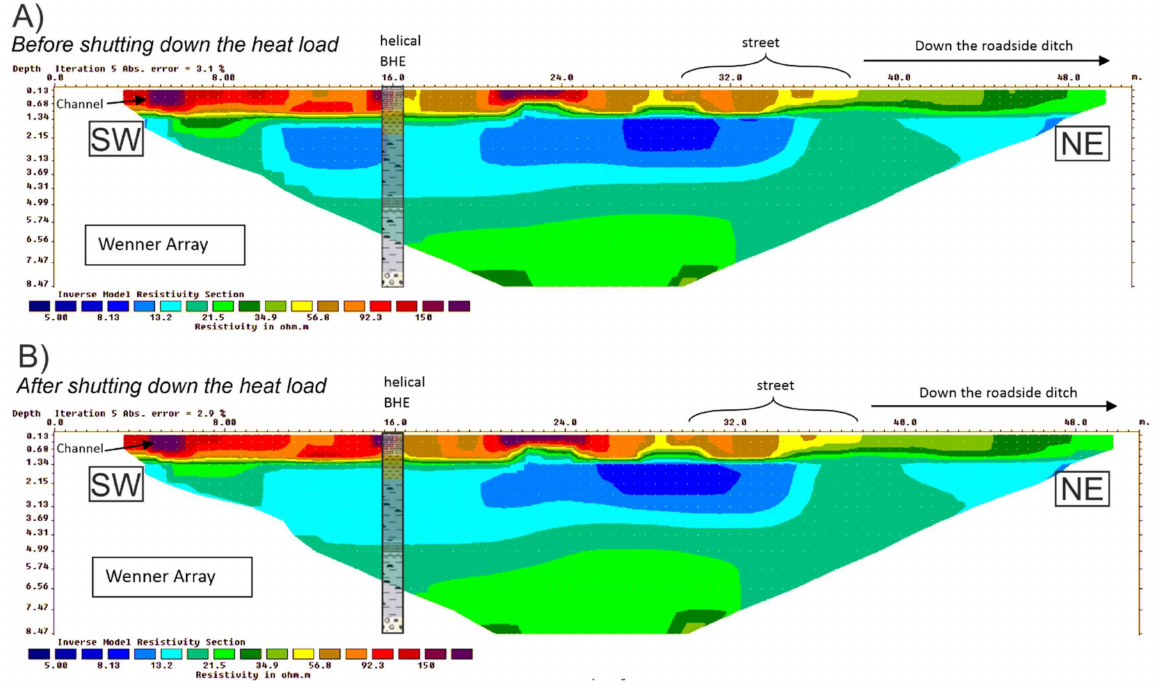
Figure 6. This figure shows the inverted electrical resistivity results before ( A ) and after shutting down the heat load ( B ) from the southwest (SW) to the northeast end (NE) by depicting the fifth iteration with errors of 3.1% and 2.9%, respectively. The ERT line at the Valencia test site passed over the helical BHE where the heat load was applied. At the position of the helical BHE the lithological column was implemented. The resistivity values are plotted on a logarithmic